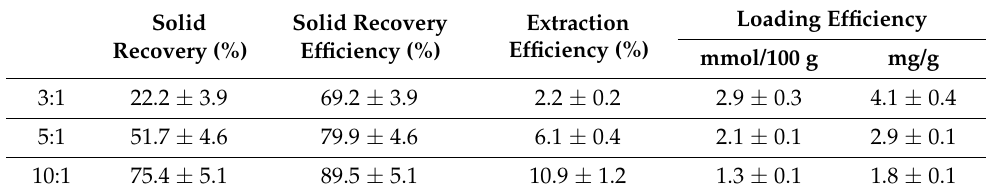
Table 1. Solid recovery, extraction, and loading efficiencies for a 10 mM Tyr solution.